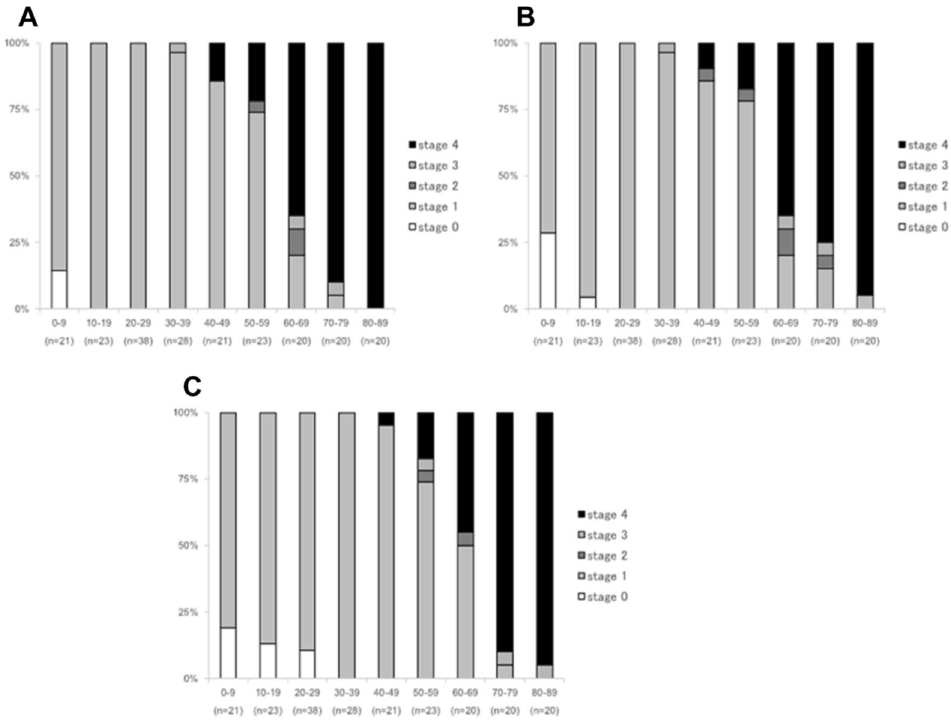
Figure 1. Proportion of subjects in each stage of posterior vitreous detachment by decade of life. Percentages for each stage of PVD (( A ) eyes with more advanced PVD stage, ( B ) right eyes, ( C ) left eyes) are displayed by age group.